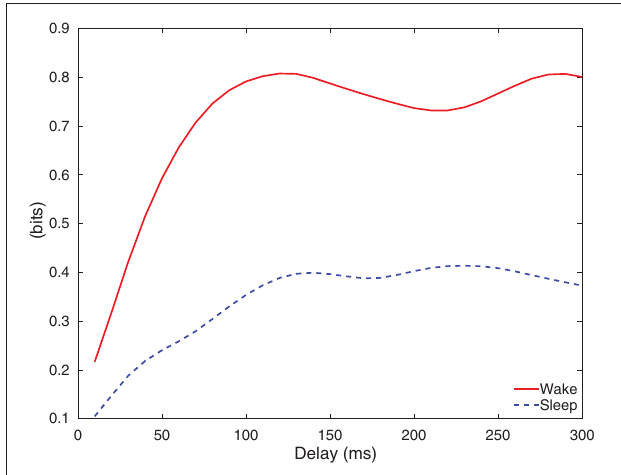
FIGURE 11 | Integrated information of Subject A, when the stimulation current is of 5mA.